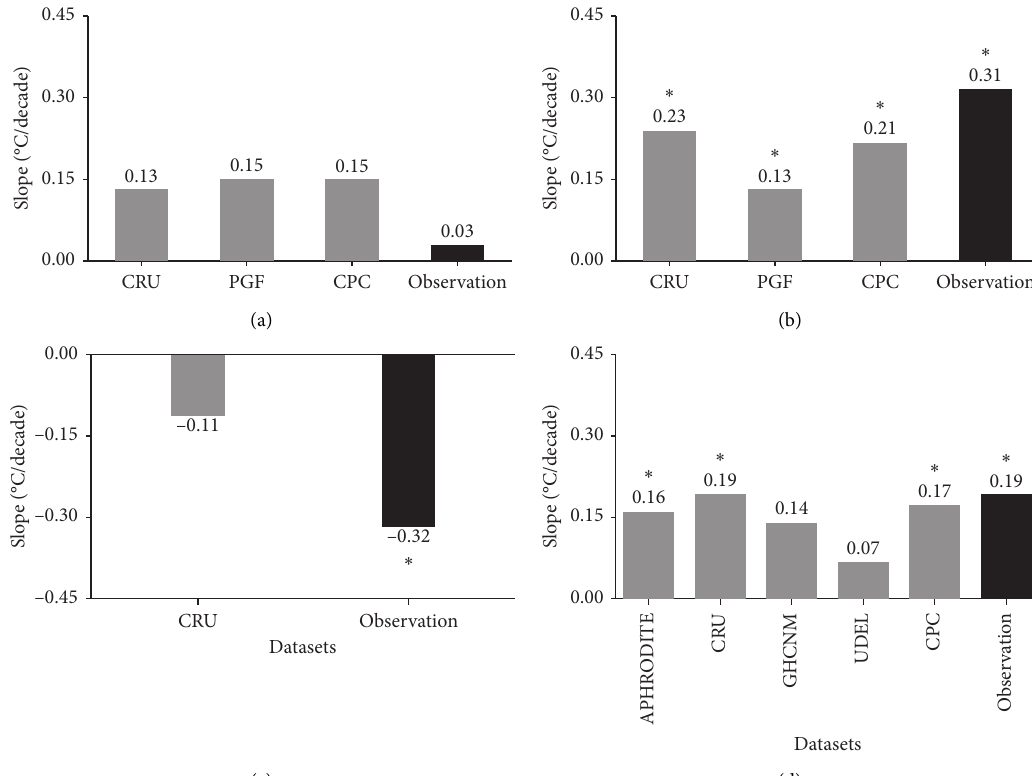
max , (b) T min , (c) DTR,